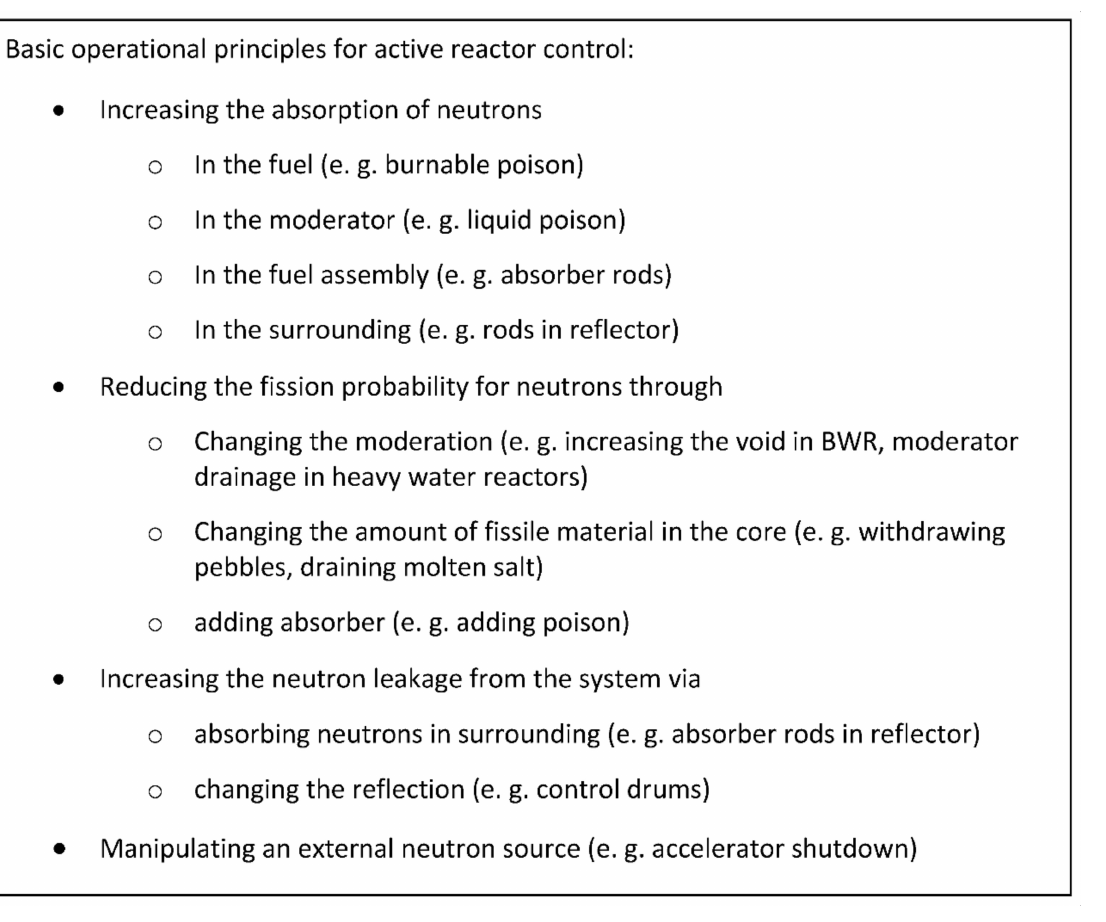
Figure 1. Basic principles of the control of reactivity in a